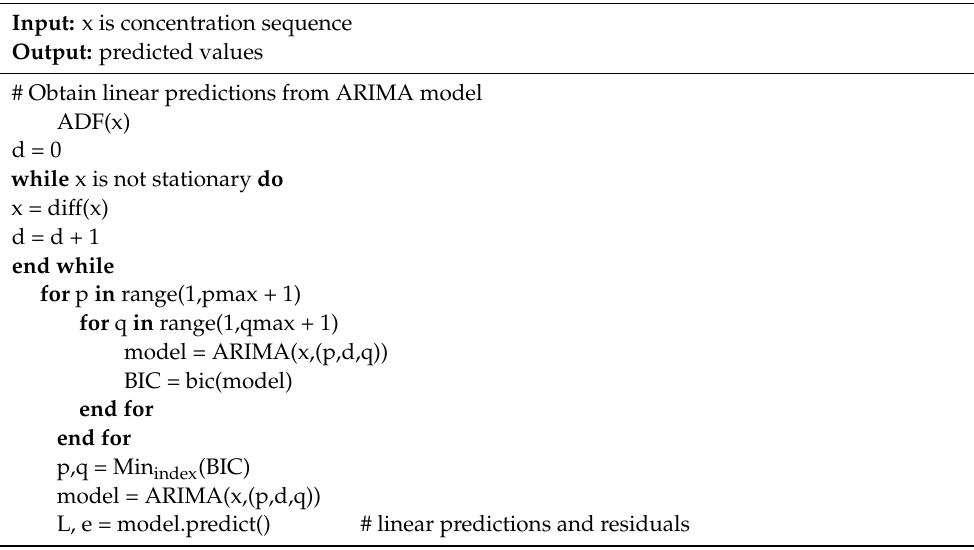
Algorithm 1. Description of algorithm of our